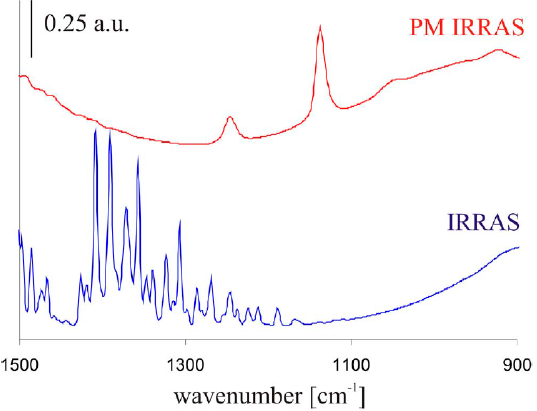
Figure 3. A comparison of PM-IRRAS and IRRAS to detect thin layers of corrosion products, revealing the clear benefit of using PM-IRRAS. Reprinted from [50] with permission from AIP Publishing. Copyright 2014.